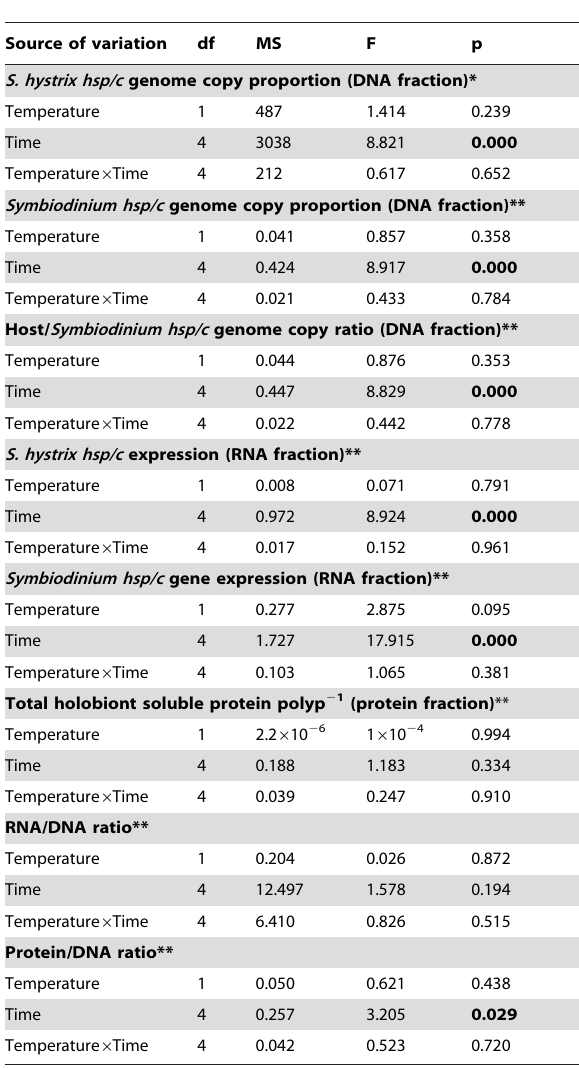
Figure 5. Host and Symbiodiniumhsp/c mRNA expression results from the thermal stress experiment. (A) Diamonds and squares represent mean host coral hsp/c expression for the control and elevated temperature treatments, respectively. (B) Triangles and circles represent mean Symbiodinium hsp/c expression for the control and elevated temperature treatments, respectively. In both panels, error bars represent standard error of the back-transformed mean, and Tukey’s post-hoc groups represent a , 0.05 significance levels for temporal variation only, as there were no significant treatment or interaction effects on host or Symbiodinium hsp/c gene expression (Table 2). In some cases, error bars do not extend beyond the icon. (C) The correlation between host and Symbiodinium log-transformed hsp/c expression across all samples.